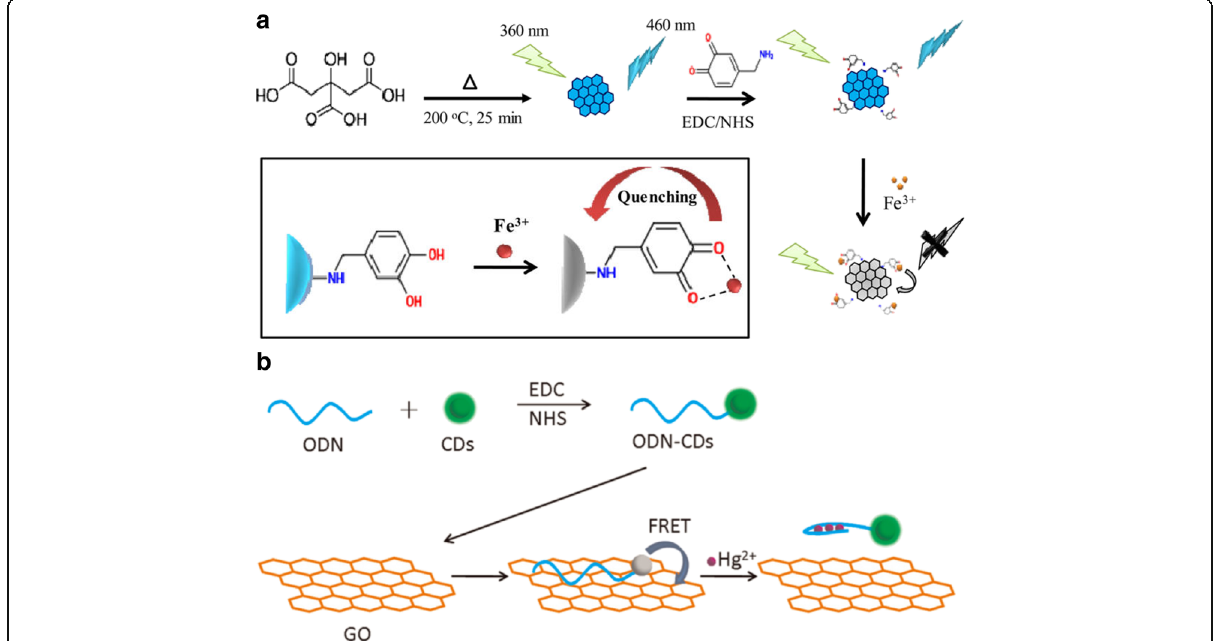
Fig. 10 Schematic of the a preparation of a dopamine-functionalized GQD (DA-GQD) sensor [89], and b the proposed mechanism for Fe 3+ ions and the FRET-based sensor system for Hg 2+ detection using CDs and GO [91]